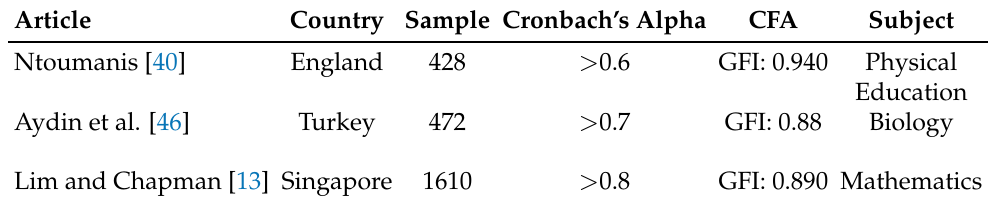
Table 1. Main studies on the application of AMS in elementary and secondary school by subject